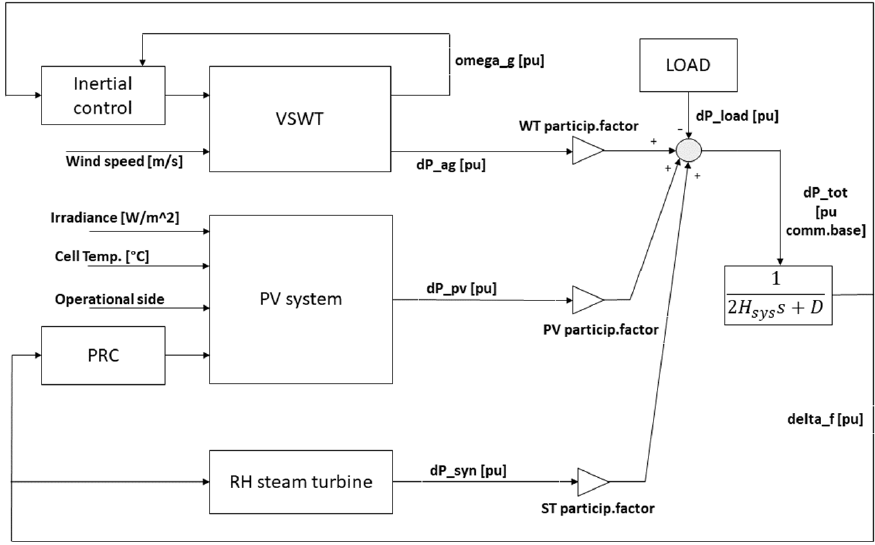
Figure 4. General layout of the model.